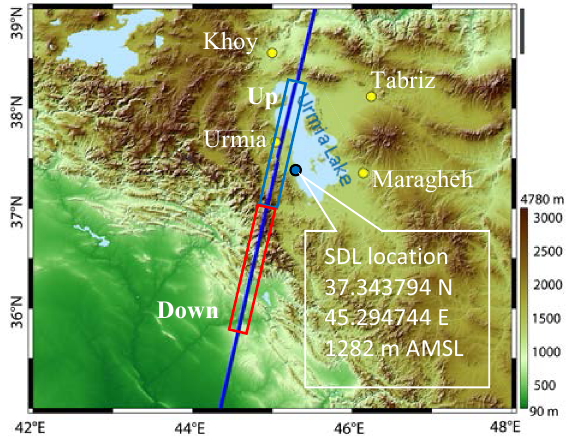
Figure 1 Orographic map of the Urmia Lake water catchment area in Northwest Iran and a night-time CALIPSO ground track over it. Blue spot at the west coast of the lake is the location of the installed lidar.